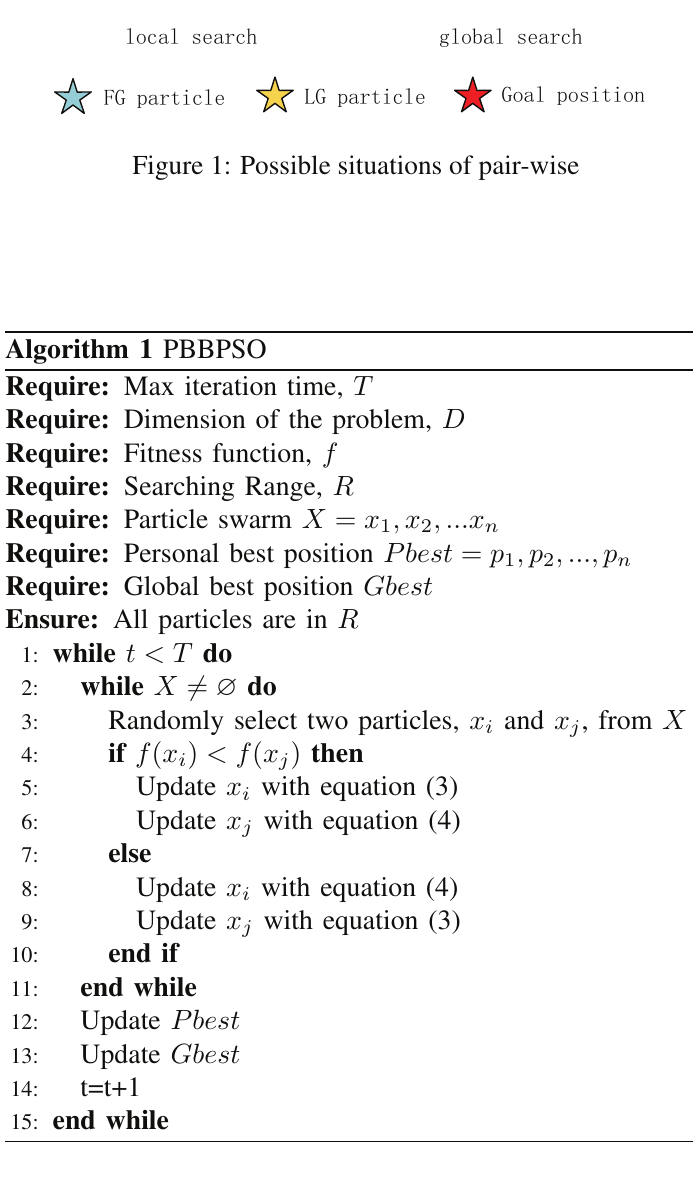
Figure 2: Pseudo code of